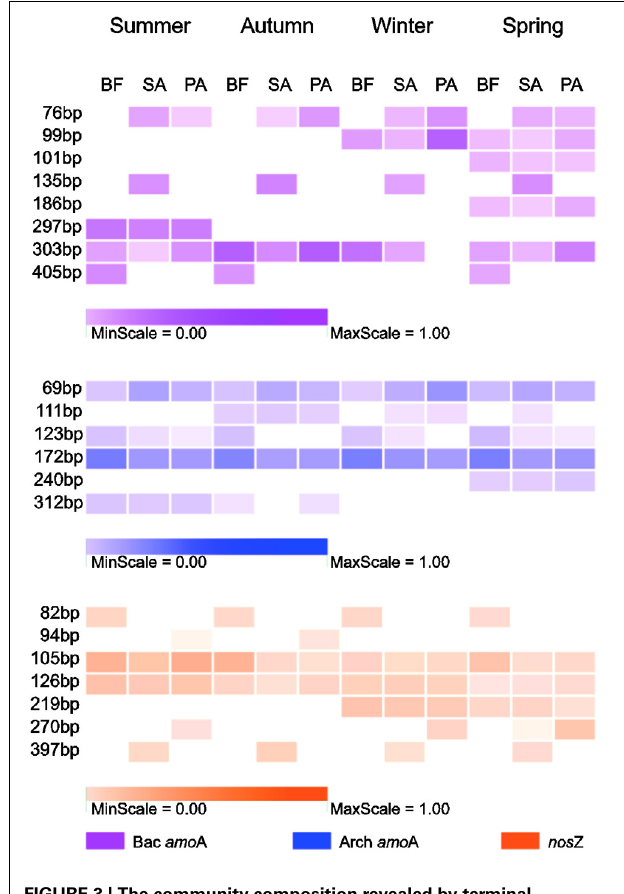
FIGURE 3 | The community composition revealed by terminal restriction fragment polymorphism (T-RFLP) analysis of the corresponding genes (Bac amoA , amoA gene of AOB; Arch amoA , amoA gene of AOA; nosZ , nosZ gene of denitrifier). The colored squares represent relative proportions of terminal restriction fragment (T-RF) during four seasons in three soil types. BF, soil at bare flat; SA, soil covered by Spartina alterniflora ; PA, soil covered by Phragmites australis .